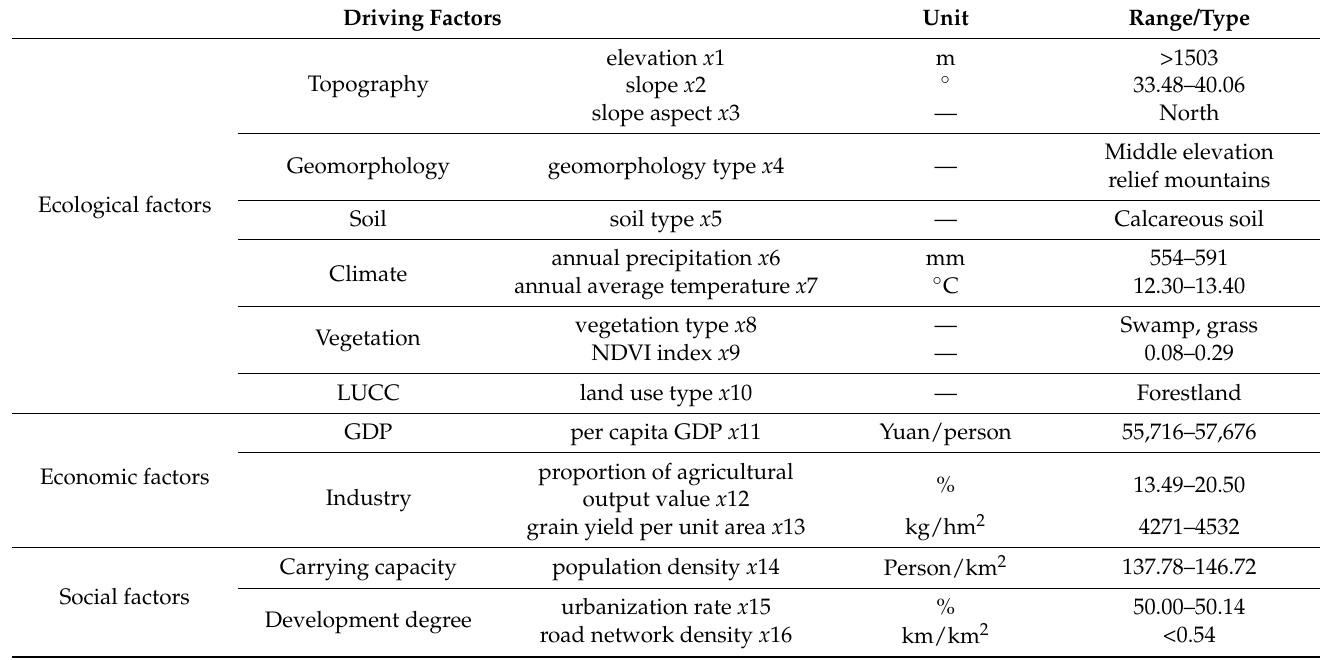
Figure 7. Spatio-temporal distribution of the degradation degree of habitat quality. Table 8. Driving factors of habitat quality change and dominant